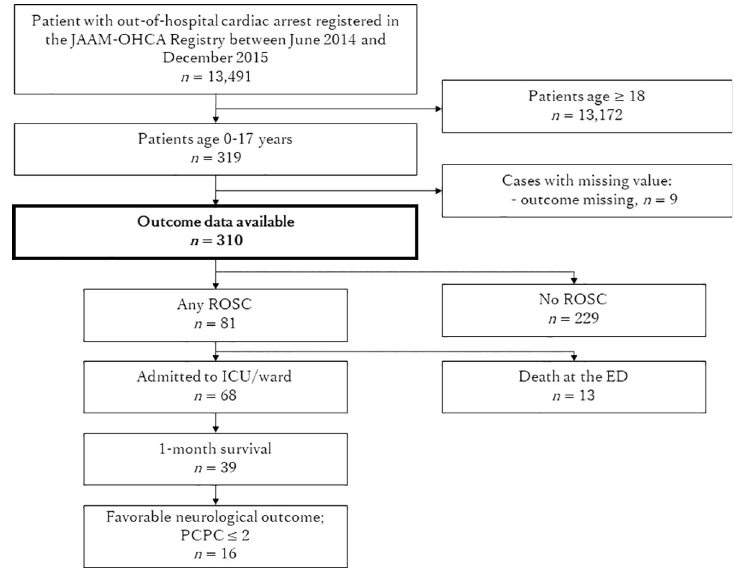
Fig 1. Patients selection flow